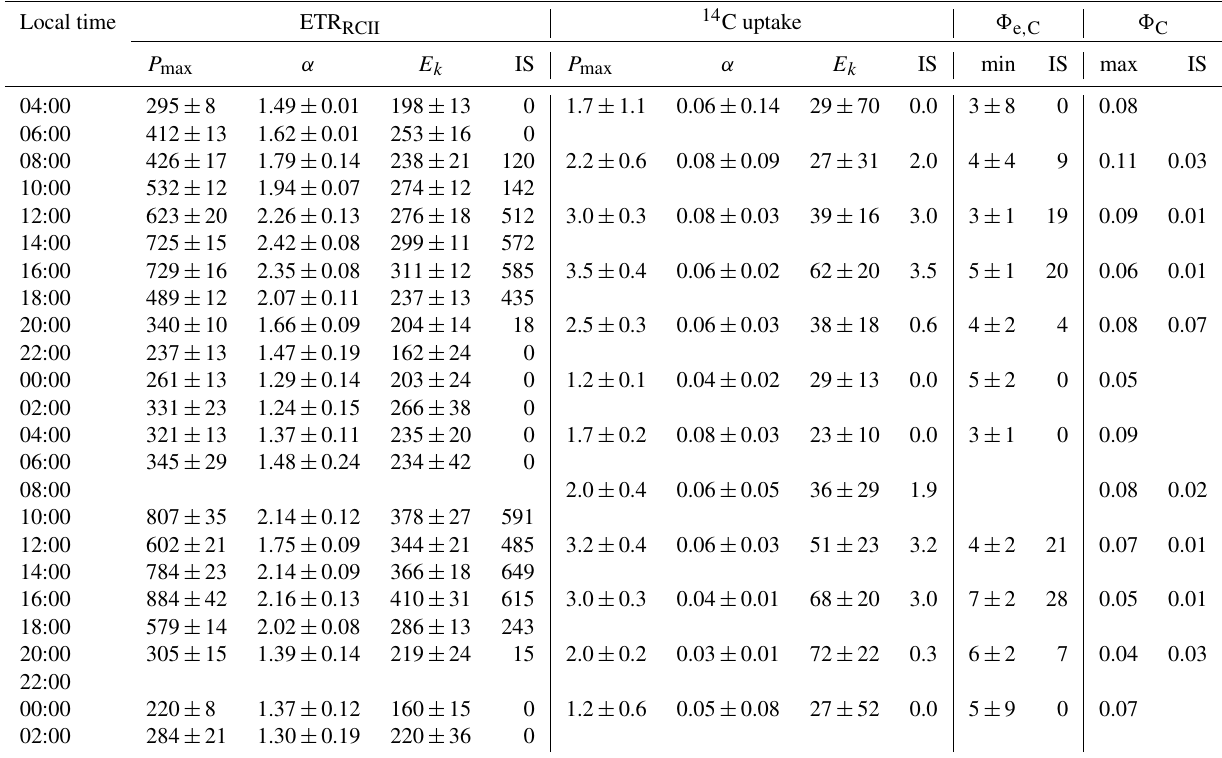
Table 3. Light-response curve fit parameters for rates of charge separation in RCII (ETR RCII ) and 14 C uptake for the 48h diurnal cycle at OCE17. Units of ETR RCII are mole − molRCII − 1 s − 1 and units of 14 C uptake are gCgChl a − 1 h − 1 . P max is the maximum rate at light saturation, α is light efficiency of each rate under light limitation and E k is the light saturation parameter (µmolquantam − 2 s − 1 ). The